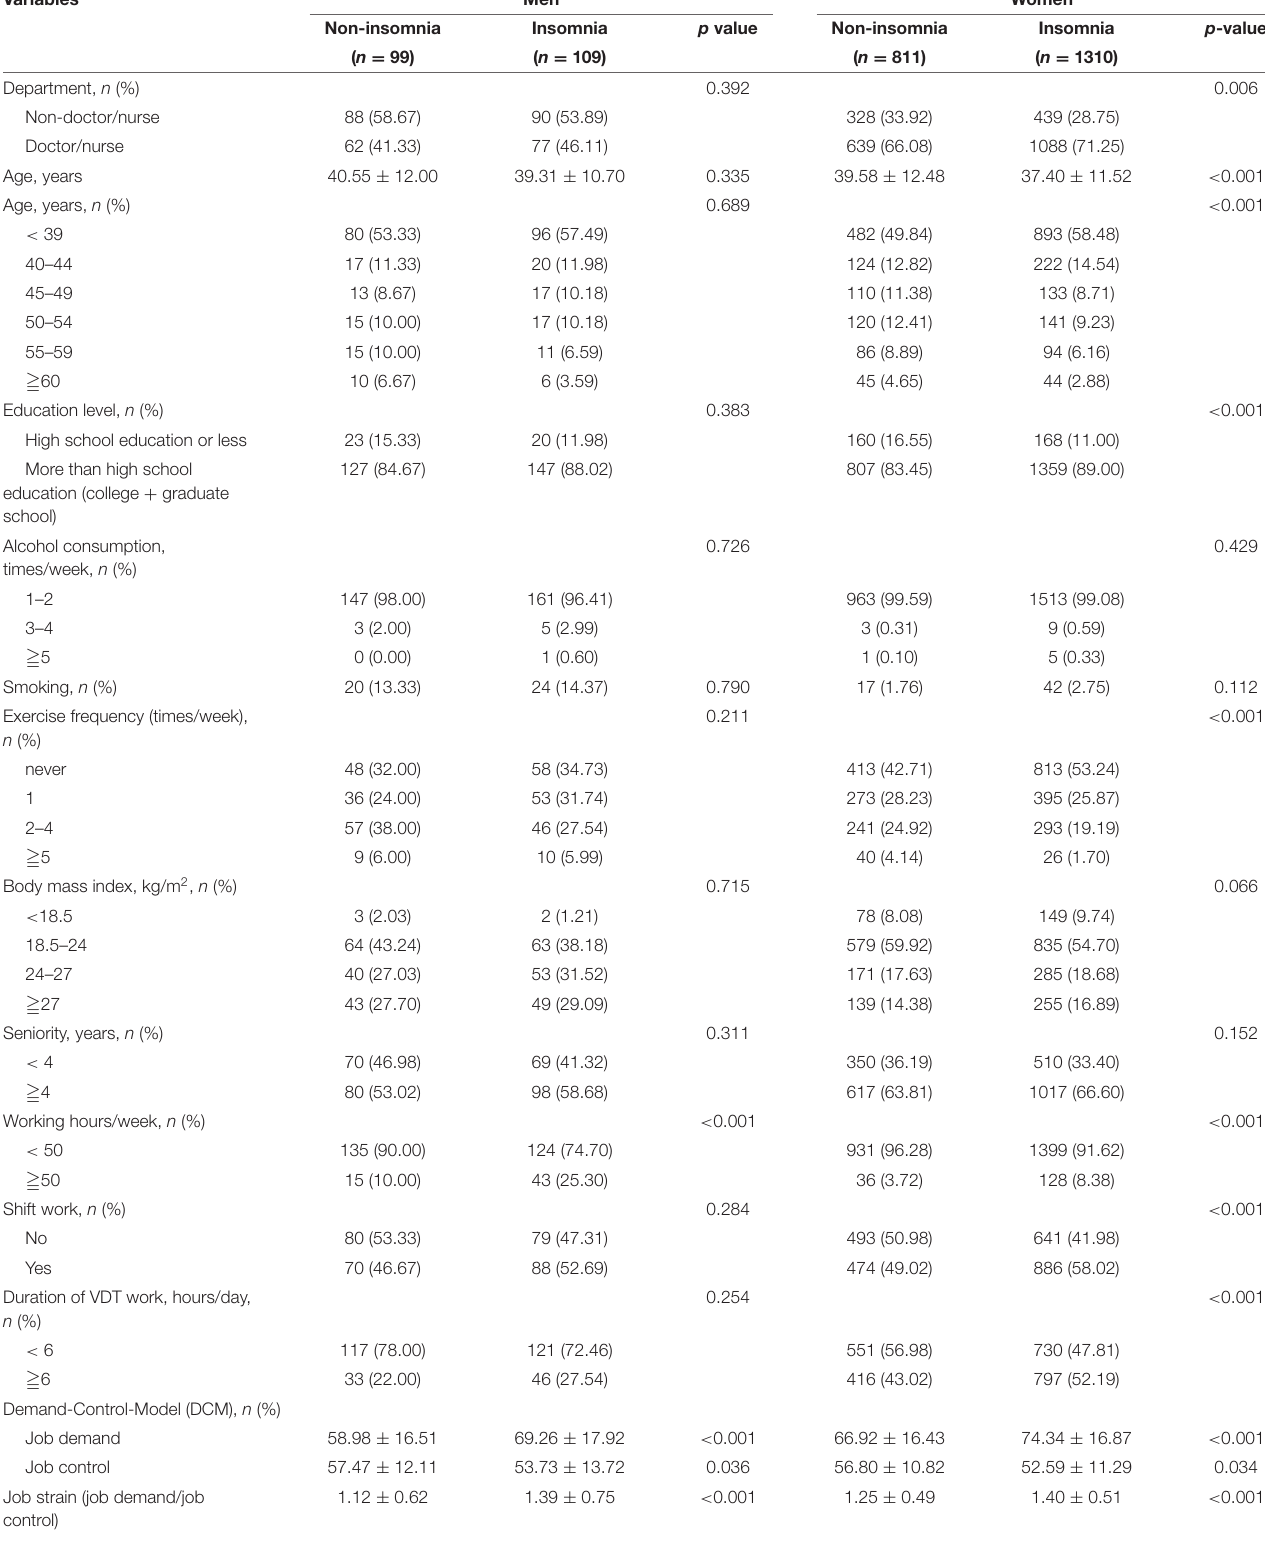
TABLE 2 | Comparison of insomnia with non-insomnia by